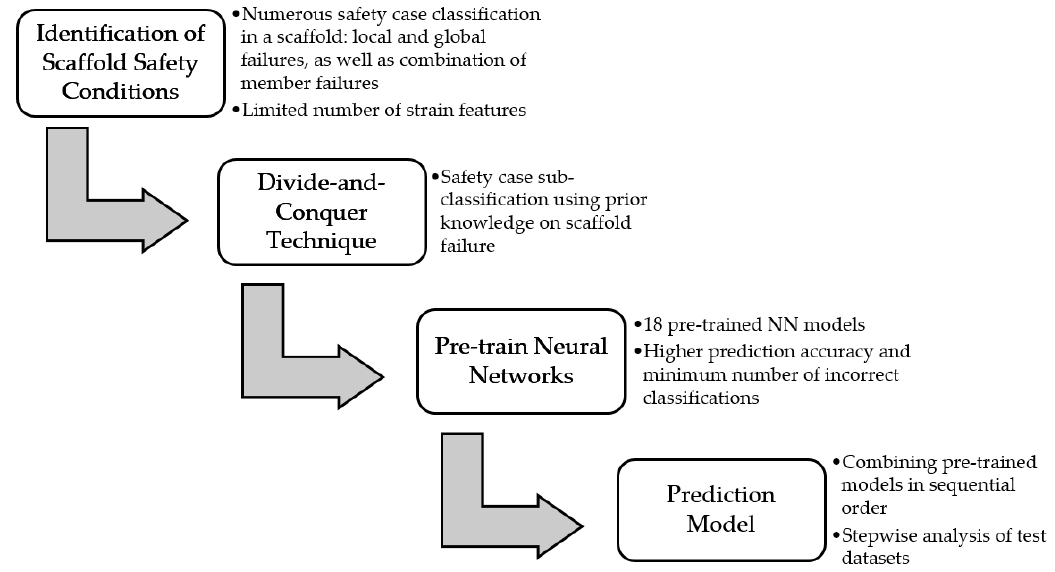
Figure 1. General approach.